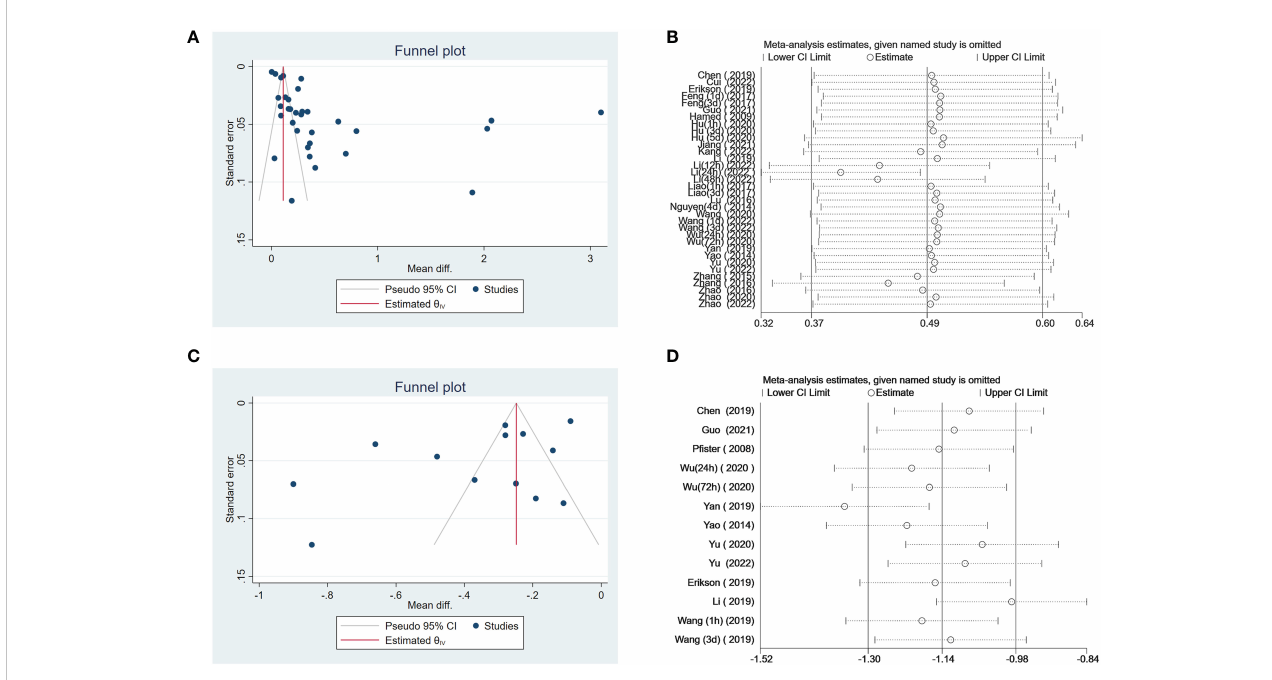
FIGURE 8 Funnel plot showed that it was asymmetry, suggesting potential publication bias may exist in association between serum S100B level and SAE (A) , association between serum S100B level and outcomes of septic patients (C) . Effect of individual studies on the pooled MD for the effect of association between serum S100B level and SAE (B) , and the effect of association between serum S100B level and outcomes of septic patients (D)